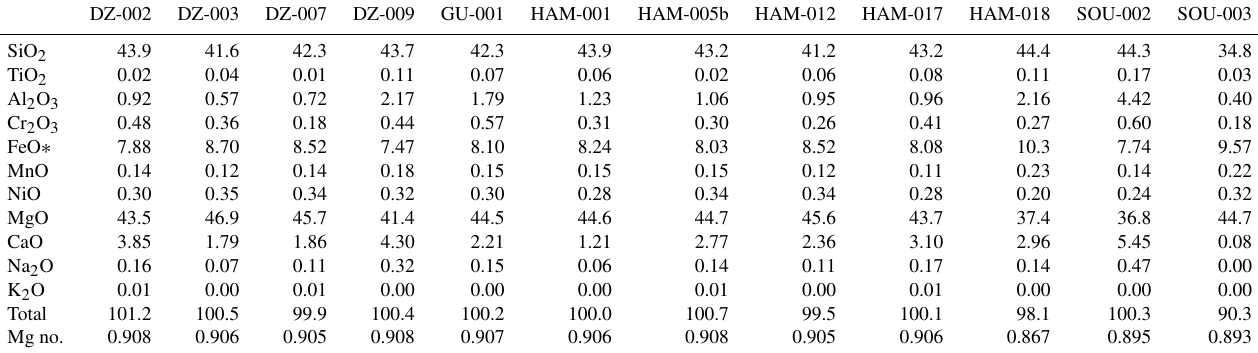
Table 2. Calculated whole-rock major element composition of the Oran mantle xenoliths. FeO ∗ : all iron as Fe 2 + ; Mg no. is Mg /( Mg + Fe ) in